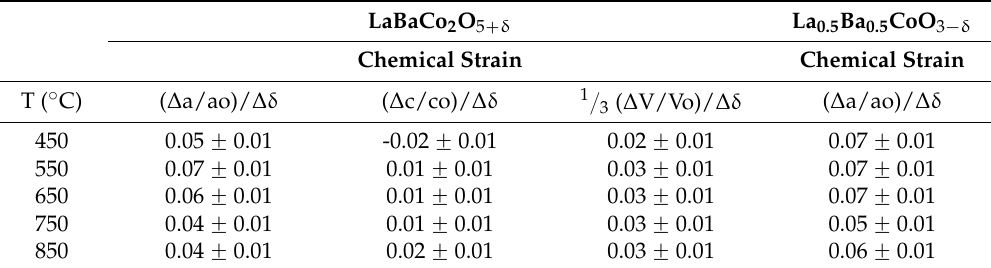
Table 3. Normalized chemical strain values for La 0.5 Ba 0.5 CoO 3 ´ δ and LaBaCo 2 O 5 ` δ